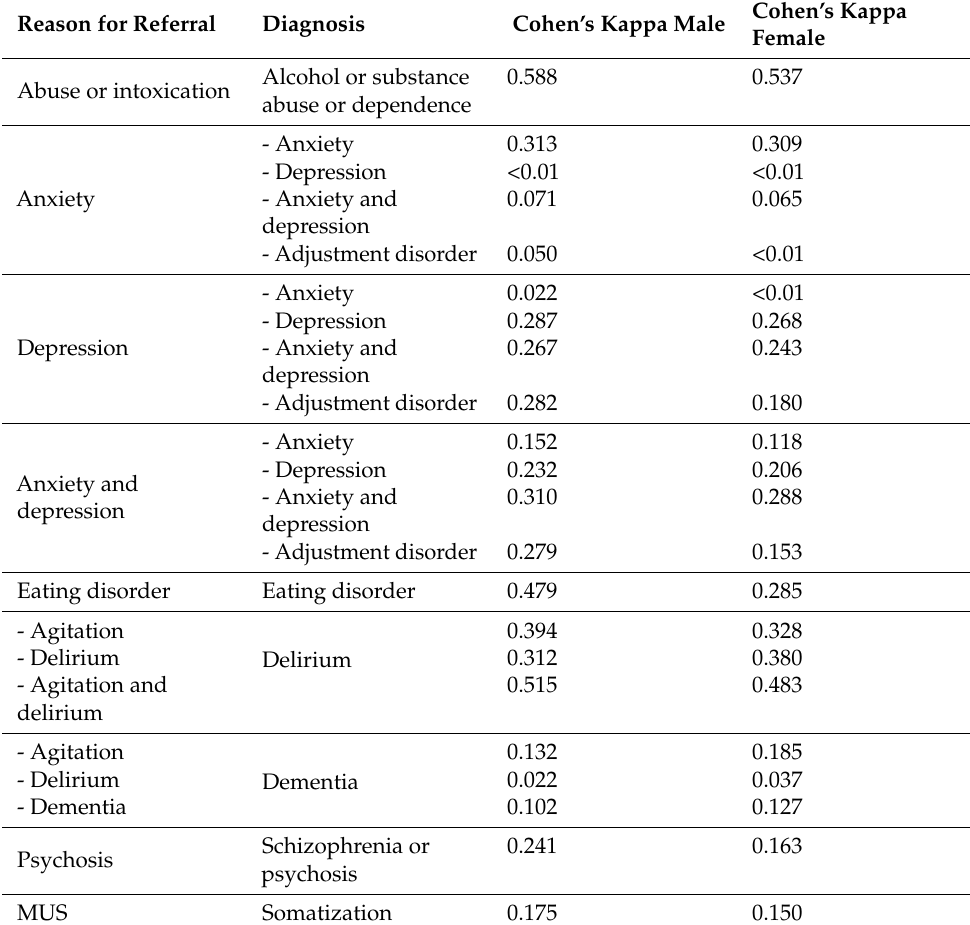
Table 7. Comparison of inter-rater agreement: Male vs. female